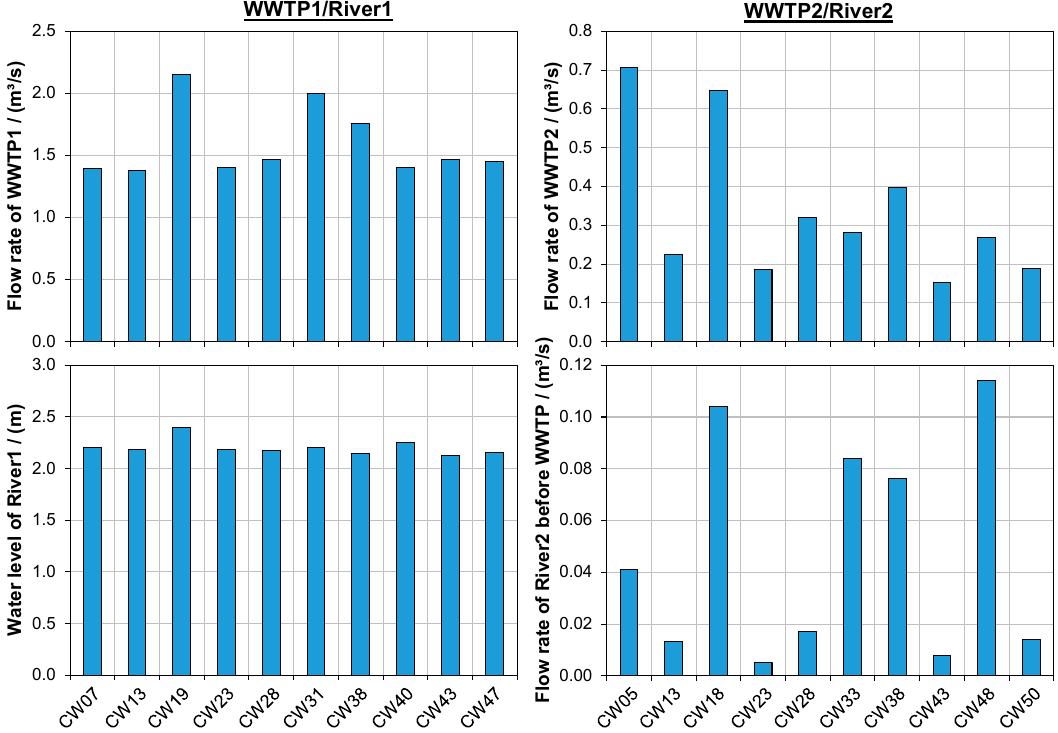
Figure A3. Flow rates of WWTPs and River2, as well as the water level of River1, during sampling in different calendar weeks (CW).